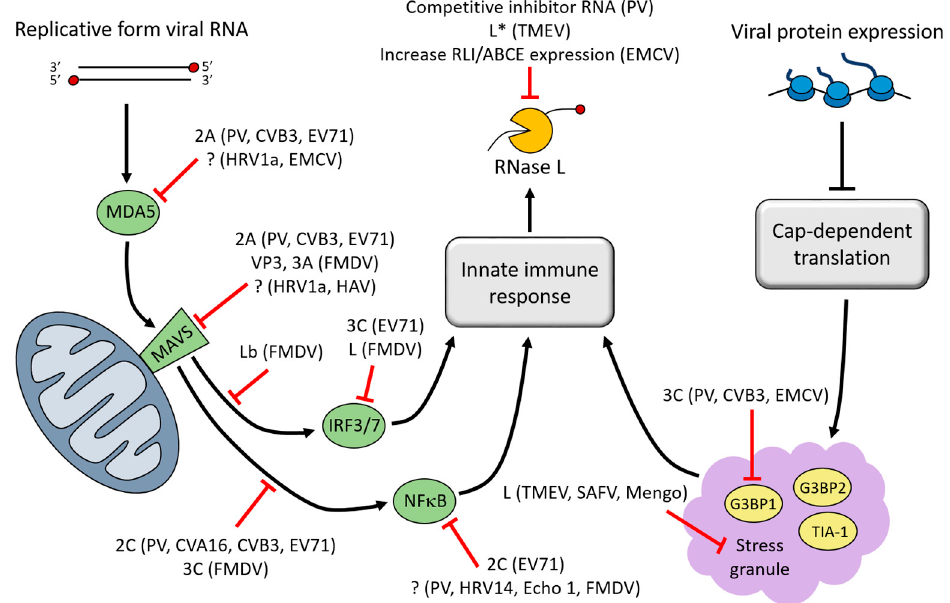
Figure 2. Inhibition of ribonuclease L (RNase L) activation by picornavirus proteins. RNase L is an effector molecule of the innate immune response. In its active form, RNase L endonucleolytically cleaves viral RNA (vRNA). Several picornaviruses have been shown to inhibit RNase L directly through binding of a viral inhibitor to RNase L or up ‐ regulation of the cellular RNase L inhibitor, RLI/ABCE. Picornaviruses also indirectly prevent activation of RNase L through extensive disruption of pathways that contribute to the innate immune response. The signaling cascade that is initiated by MDA5 following detection of viral double ‐ stranded RNA is disrupted at multiple steps during infection, which prevents expression of interferon (IFN) ‐ induced genes and activation of RNase L. Additionally, the disassembly of stress granules (SGs) during infection inhibits SG ‐ mediated enhancement of the innate immune response. Simplified pathways are depicted here, highlighting points in the pathway that are inhibited by specific picornaviruses and the viral protein responsible (“?” indicates that the viral protein responsible is unknown). PV, poliovirus; CVA16, coxsackievirus A16; CVB3, coxsackievirus B3; EV71, enterovirus 71; Echo 1, echovirus type 1; HRV1a, human rhinovirus 1a; EMCV, encephalomyocarditis virus; Mengo, mengovirus (a strain of EMCV); TMEV, Theiler’s murine encephalomyelitis virus; SAFV, Saffold virus; HAV, hepatitis A virus; FMDV, foot ‐ and ‐ mouth disease virus.